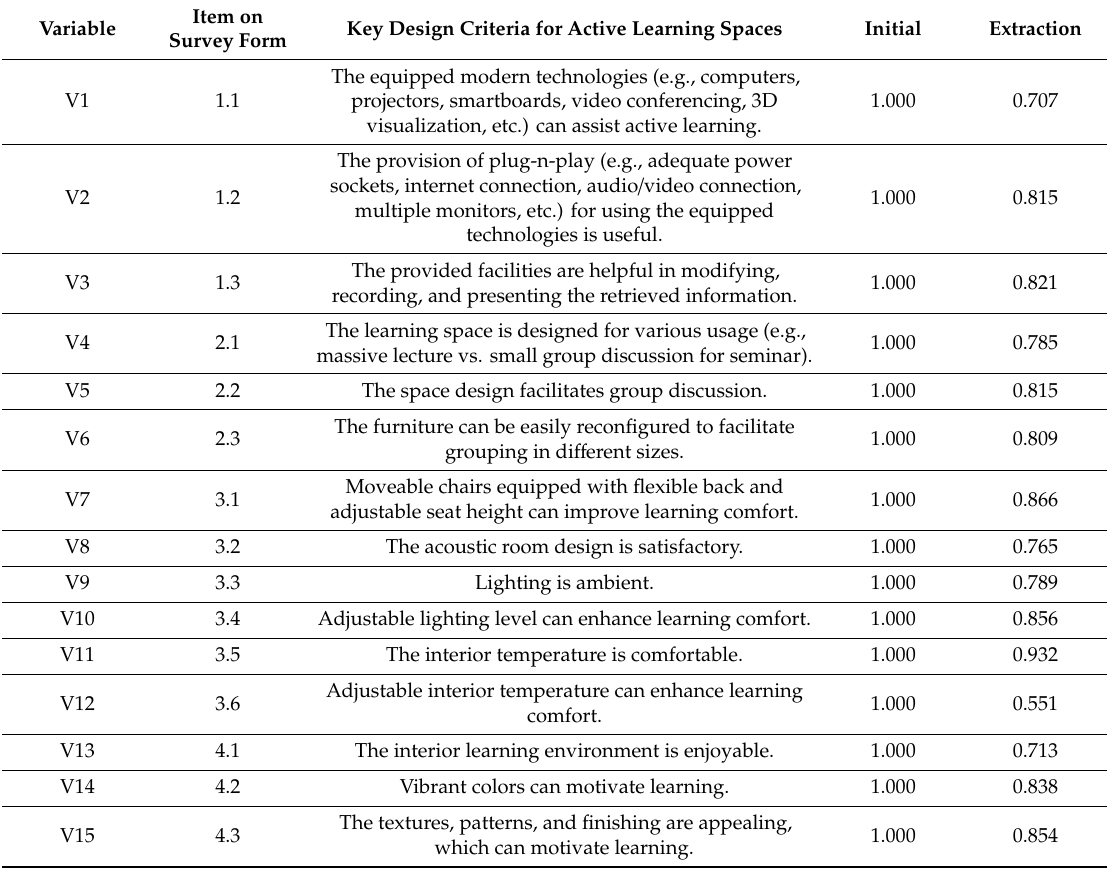
Table 2. Communality results of the key design criteria for active learning spaces after factor extraction. Variable